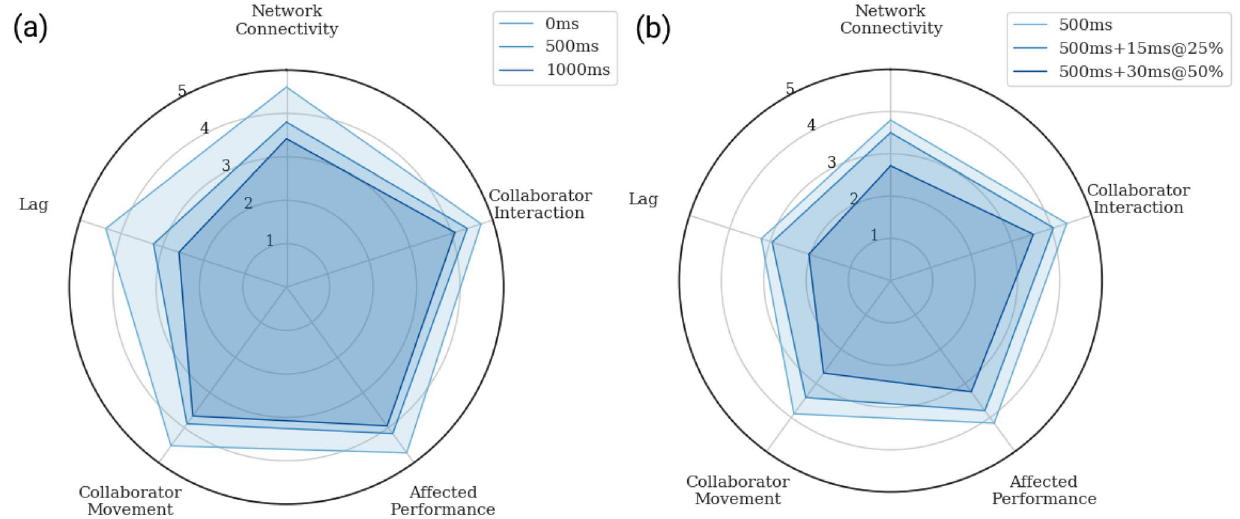
Figure 7. Questionnaire responses. ( a ) Questionnaire responses across different latencies. ( b ) Questionnaire responses across different packet burst